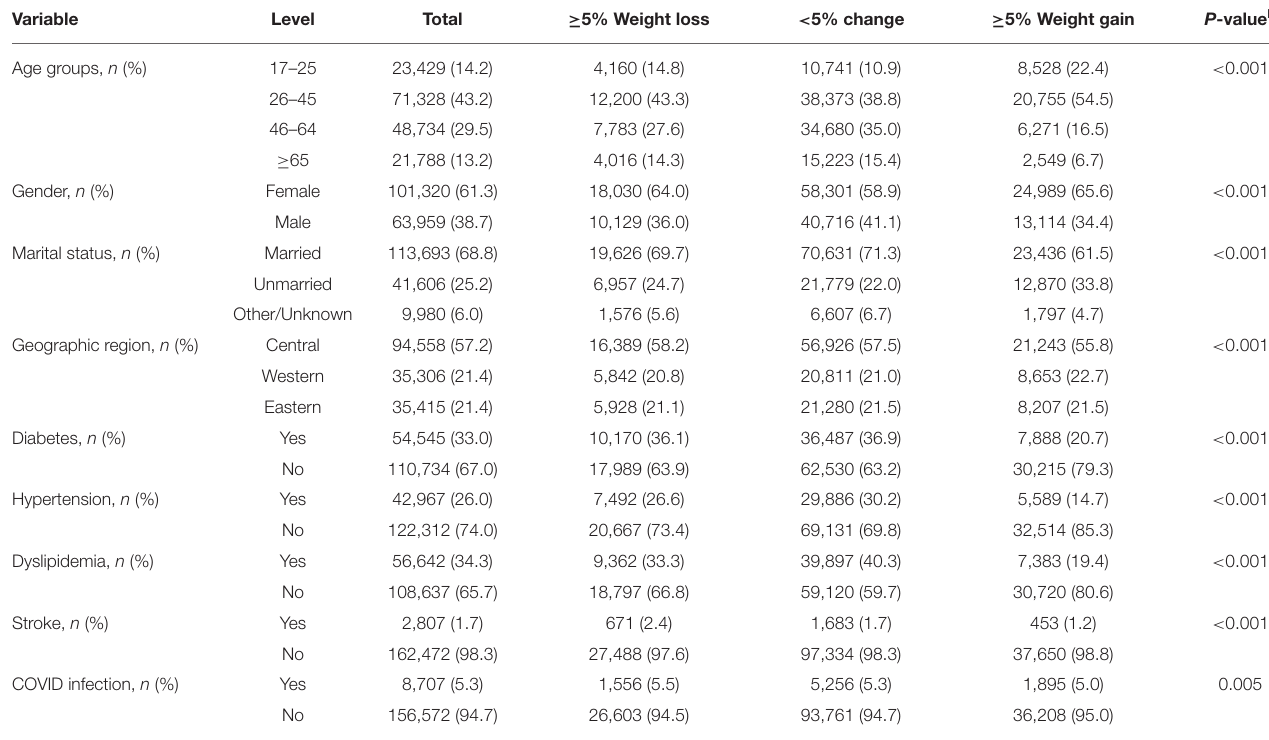
TABLE 1 | Characteristics of the study population based on the weight change status ( N = 165,279) a .